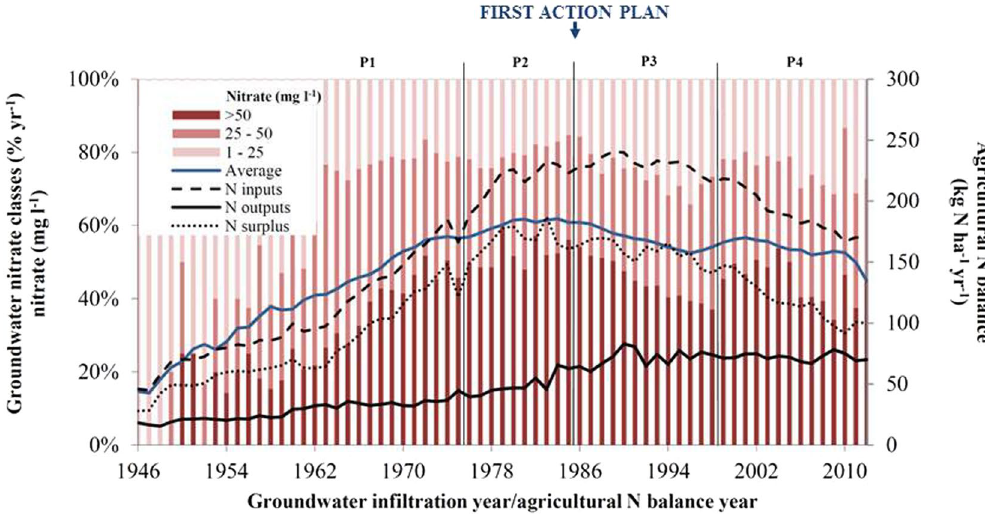
Figure 4. The annual trends of nitrate in oxic groundwater and agricultural N balances for Denmark in the four groundwater infiltration periods (P1-P4). The percentage of samples for each year is illustrated in the three groundwater nitrate classes ( > 50 mg l − 1 , 25–50 mg l − 1 and 1–25 mg l − 1 ). The 5-year moving average of the nitrate content in oxic groundwater (blue line) is based on 5,506 samples from 340 monitoring points. The annual agricultural N balances, net (N inputs, outputs and surplus) are calculated for the primary Danish agricultural sector.